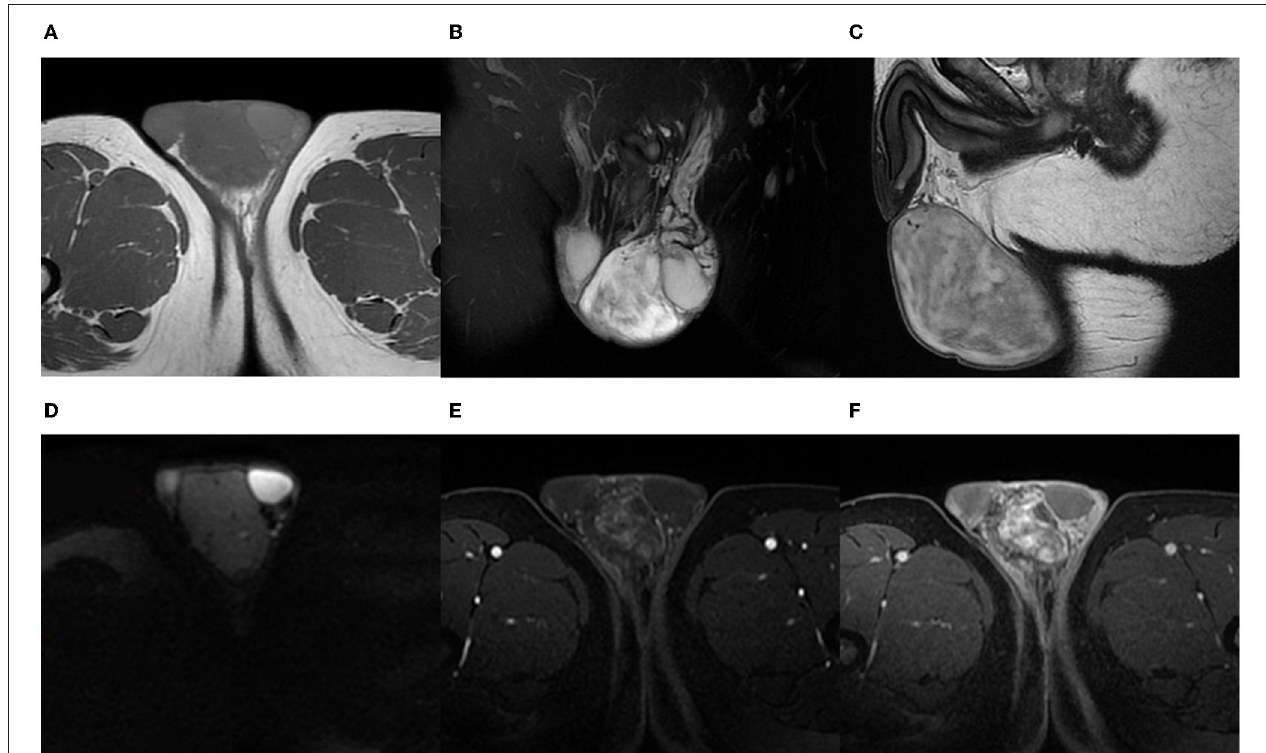
FIGURE 1 | A 42-year-old man with AMF. On T1-weighted images, the tumor reveals low signal intensity but high signal intensity in some circuitous strips (A) . On coronal fat-saturated T2-weighted images and sagittal T2-weighted images, the tumor is well-marginated with high inhomogeneous signal intensity (B,C) . DWI shows a low-signal tumor (D) . The images of contrast-enhanced MRI show a heterogeneous and distinctly enhanced mass. As time goes on, the enhancement of the tumor is more obvious (E,F)